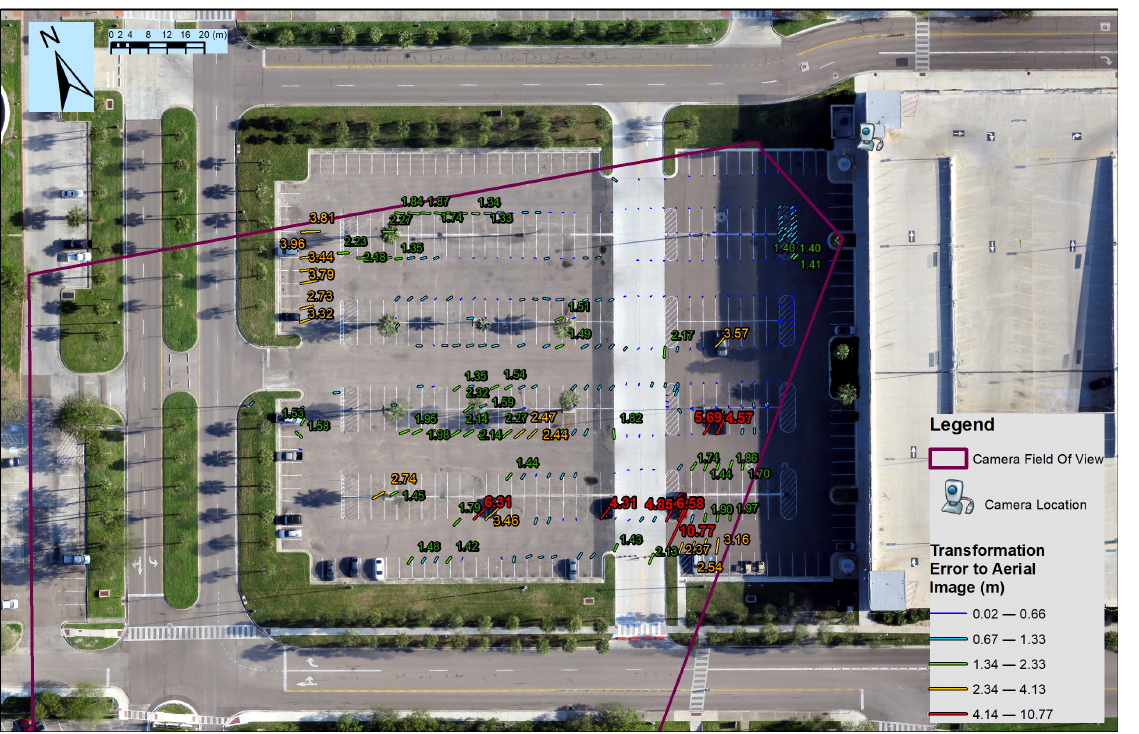
Figure 8. The amount of error present for each control point computed by the solution using all available control points. Errors less than 1.33 m are visualized but not